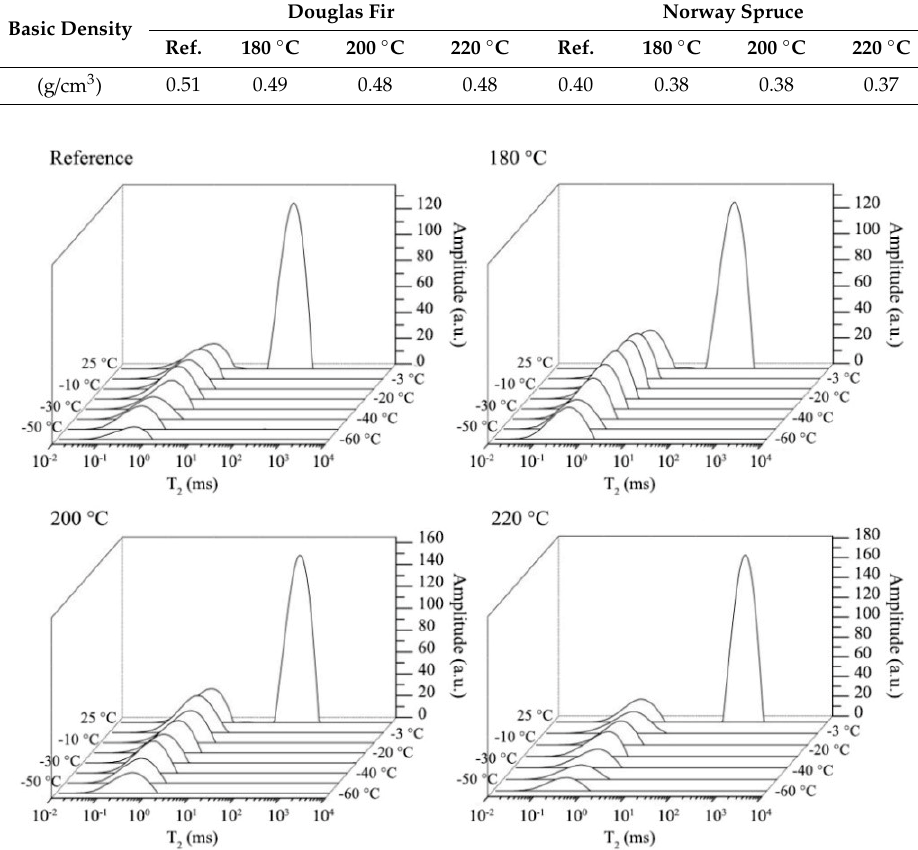
Table 2. The basic density of samples (Ref. refers to reference samples).